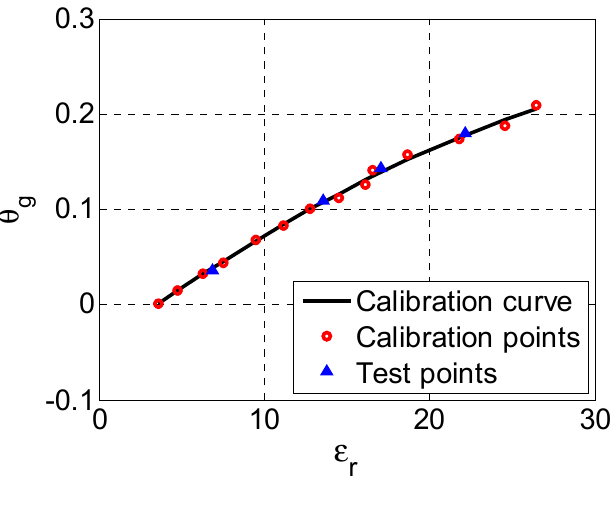
Figure 11. Calibration curve of the sensor (black line) for carbonate chernozem soil. Red circles denote calibration points, while blue triangles denote independent test